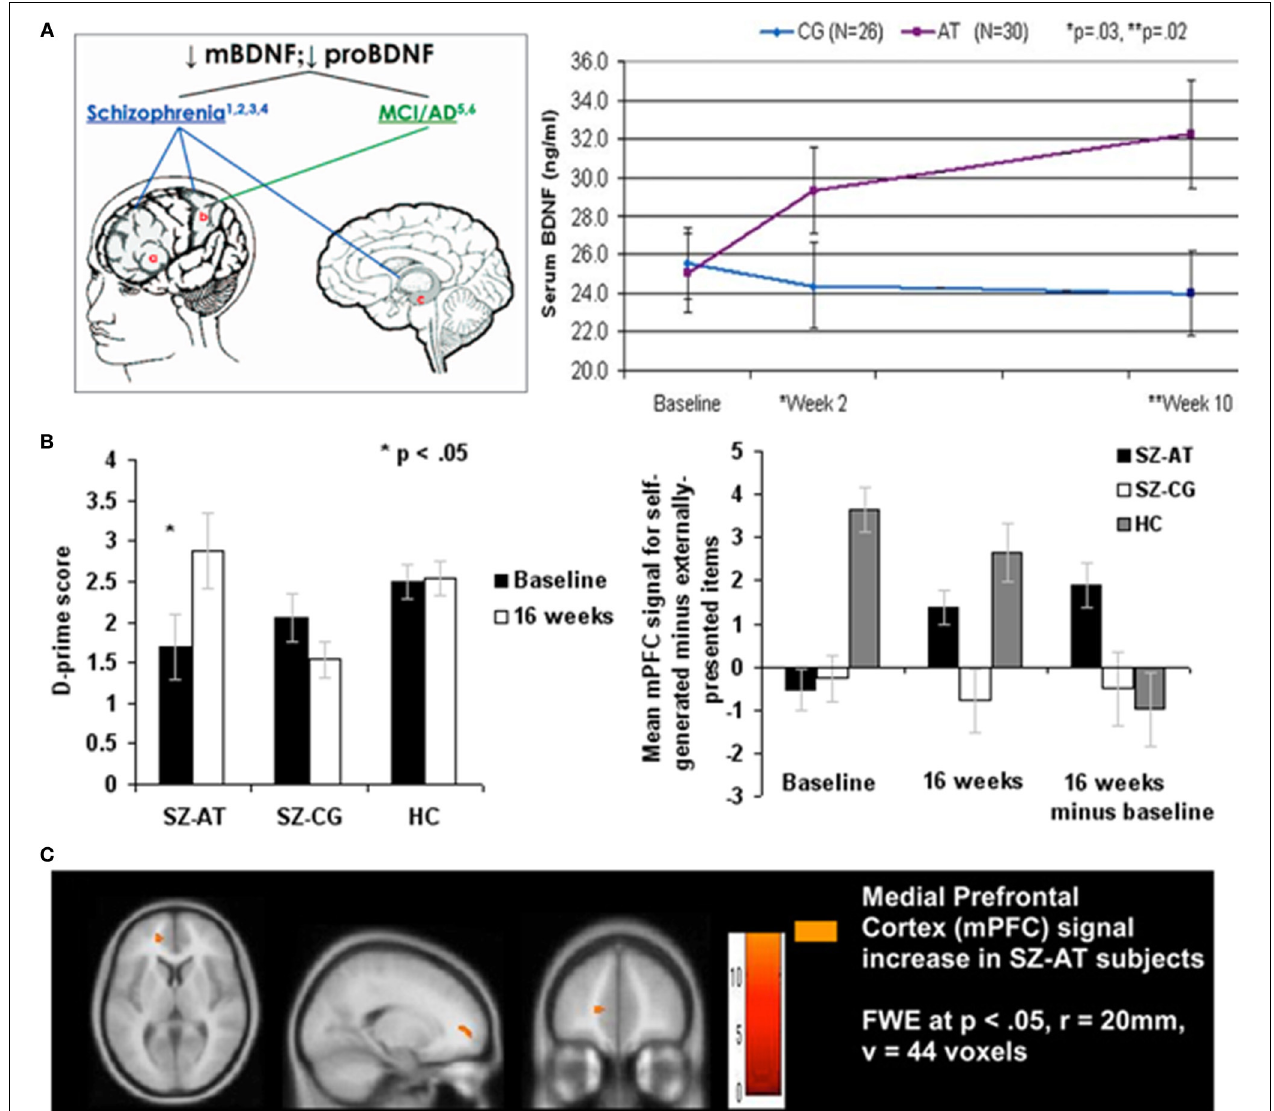
FIGURE 1 | Illustrating positive far-transfer chemical, behavioral, and brain response changes attributable to intensive brain training in patients with chronic schizophrenia (SZ). Tasks targeted the auditory-aural language/perceptual-cognitive system. Training was via computers, over a 40–50 hour-long training period. (A) Brain-Derived Neurotrophin Factor (BDNF) in its “pro” and mature (“m”) forms is down-regulated in schizophrenia and in other chronic neurological and psychiatric illnesses (e.g., healthy aging). As a result of this brain plasticity-based training, serum levels of BDNF were elevated to normal levels; no changes were recorded in subjects who worked with equivalent intensity on progressive control video games. The up-regulated of BDNF to near-normal levels was sustained for more than a year following training program completion. Similar effects have been recorded in aging brains. Data are from Vinogradov et al. (2009). (B)